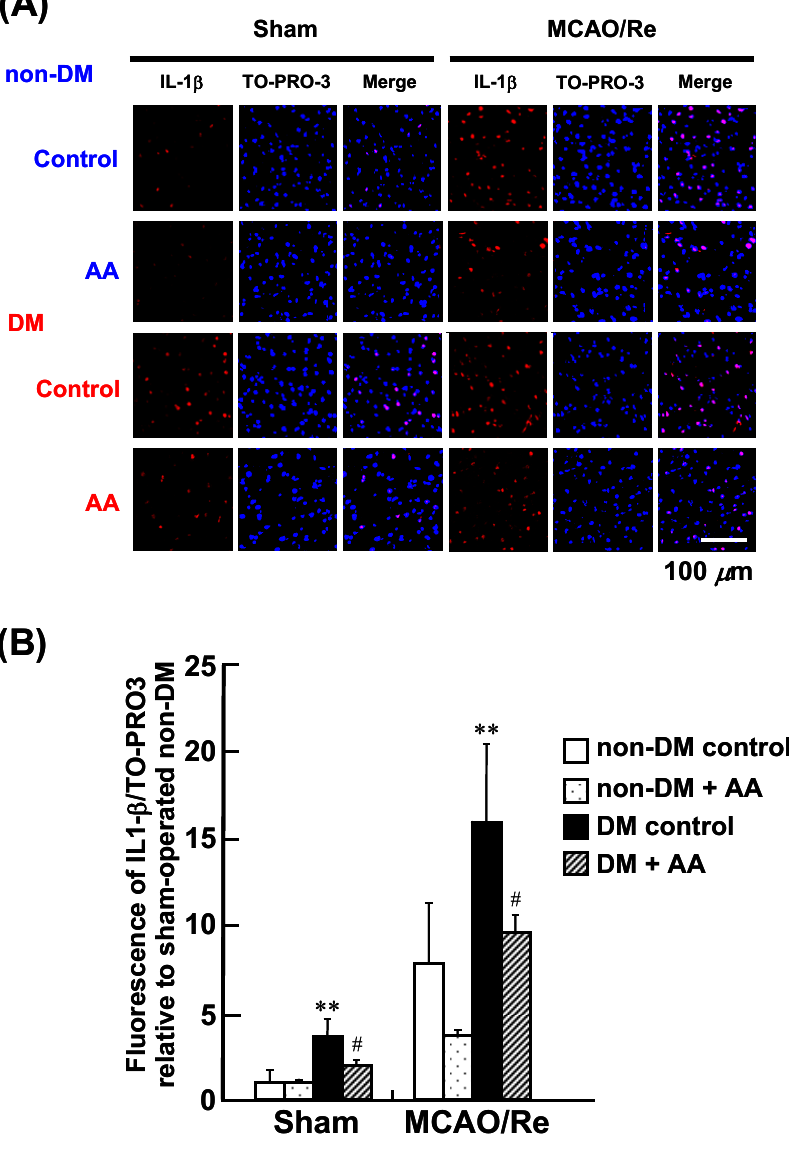
Figure 5. Effects of AA supplementation on expression of IL-1 β in the penumbral